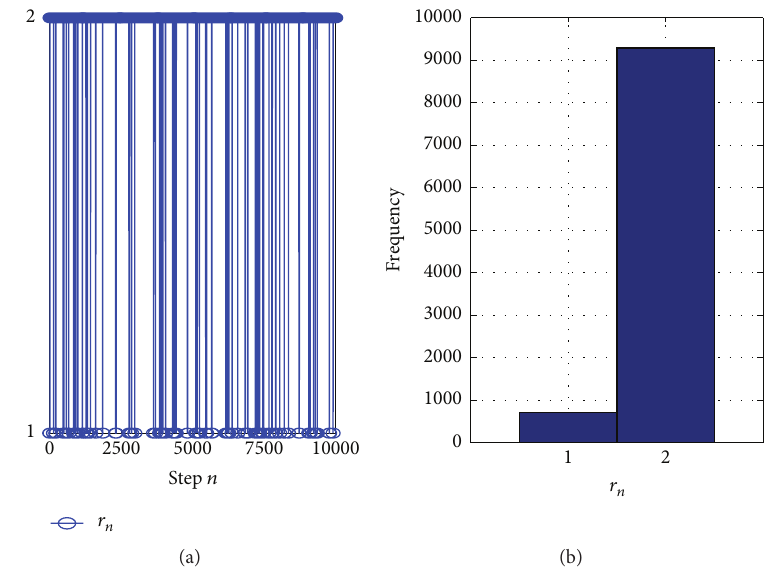
Figure 7: The above subgraphs have the same notations as in Figure 4. The change of 𝑟 𝑛 in (a) means the process of regime switching of system (5) between subsystems (64) and (65). And the frequency of 𝑟 𝑛 in (b) shows the result of regime switching—the total number of steps of the overall system (5) switching to subsystem (64) or subsystem (65). This graph means that under the control of the Markov chain the overall system (5) mostly switches to subsystem (65) in Case 2 of Example 1.